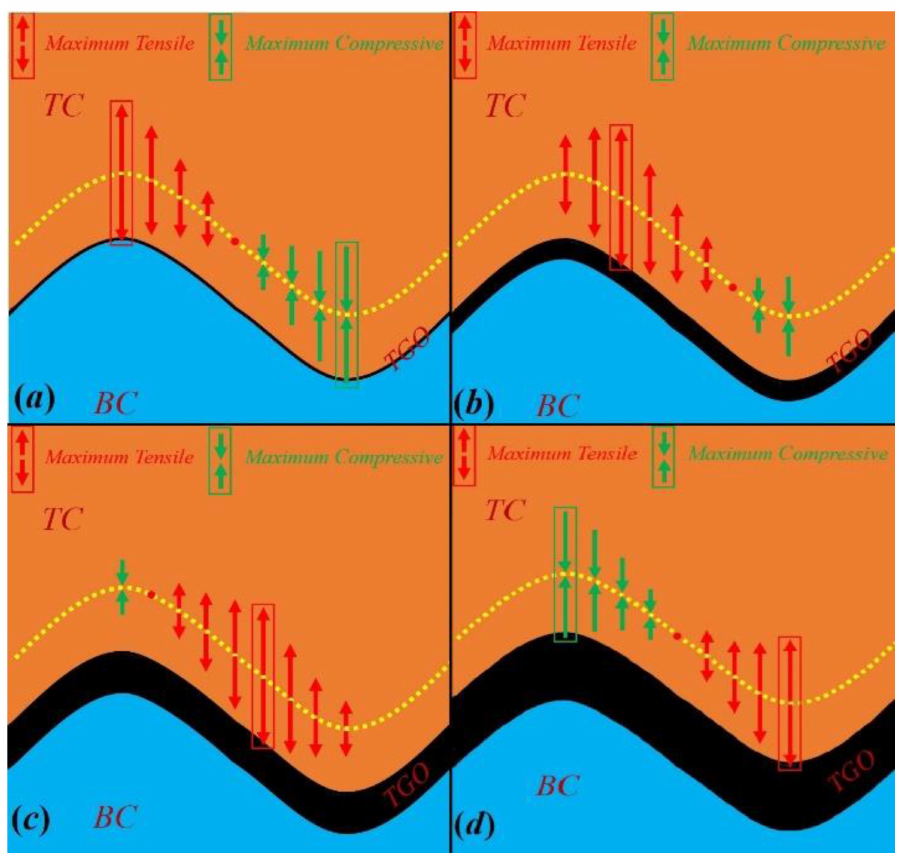
Figure 5. The variation in the maximum tensile zone vs. TGO thickness. The positions of the maximum out-of-plane tensile stress are identified ( a ) at the peak of TC at early stage of thermal cycles; ( b ) at flank close to the peak of TC as the TGO thickens; ( c ) at flank close to the valley of TC at post-failure stage of life cycles; and ( d ) at valley of TC when TBCs fail due to formation of delamination cracks along the